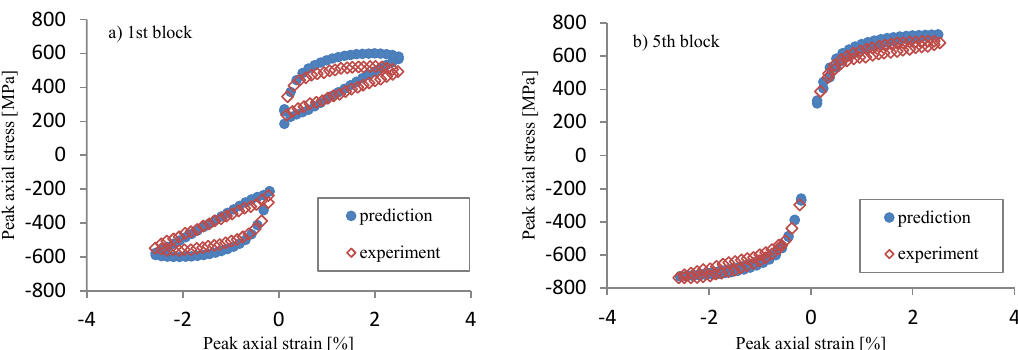
Figure 8. Comparison between a prediction and an experiment in the form of the variation in tensile peak stress for the incremental test (the experiment was taken from [15]): ( a ) first block, ( b ) fifth block.